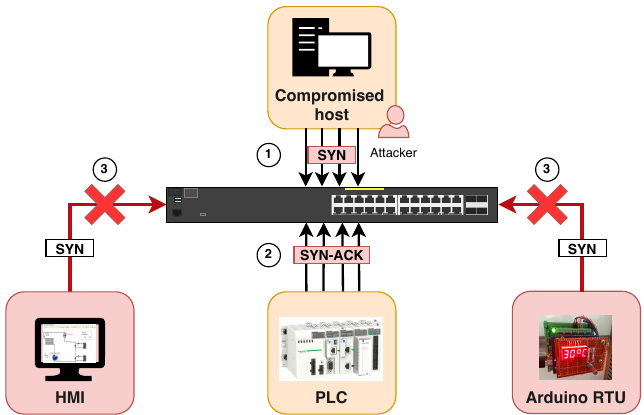
Figure 19. SYN flood effect on the SCADA